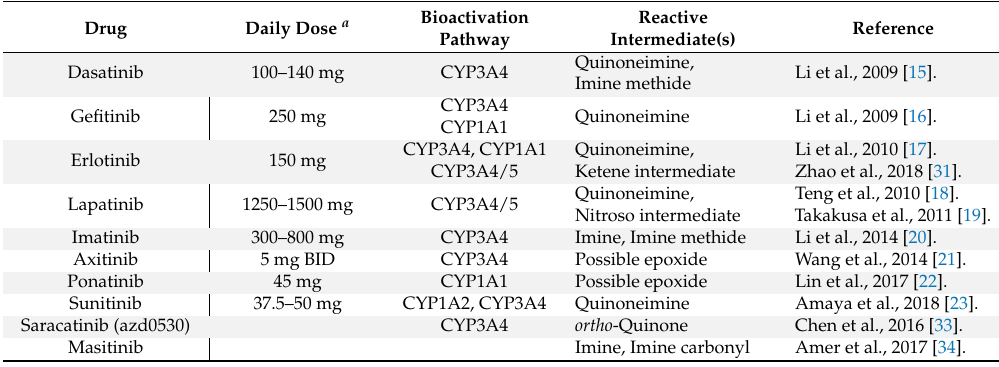
Table 2. Tyrosine Kinase Inhibitors Reported to Form Reactive